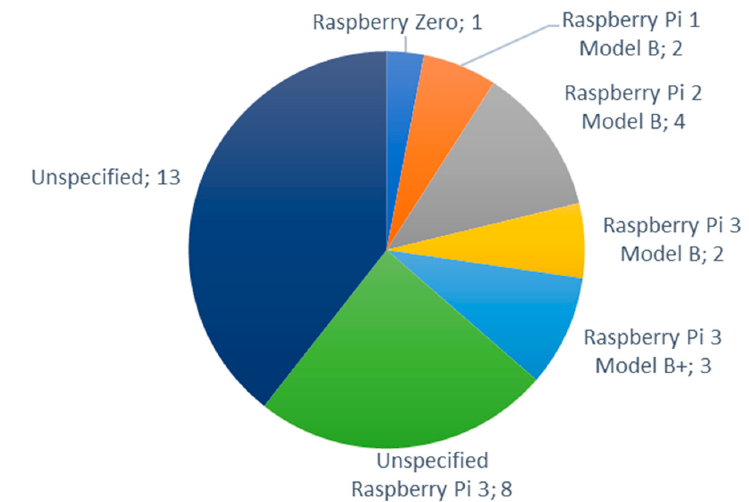
Figure 23. Raspberry Pi nodes utilized to implement IoT irrigation systems.